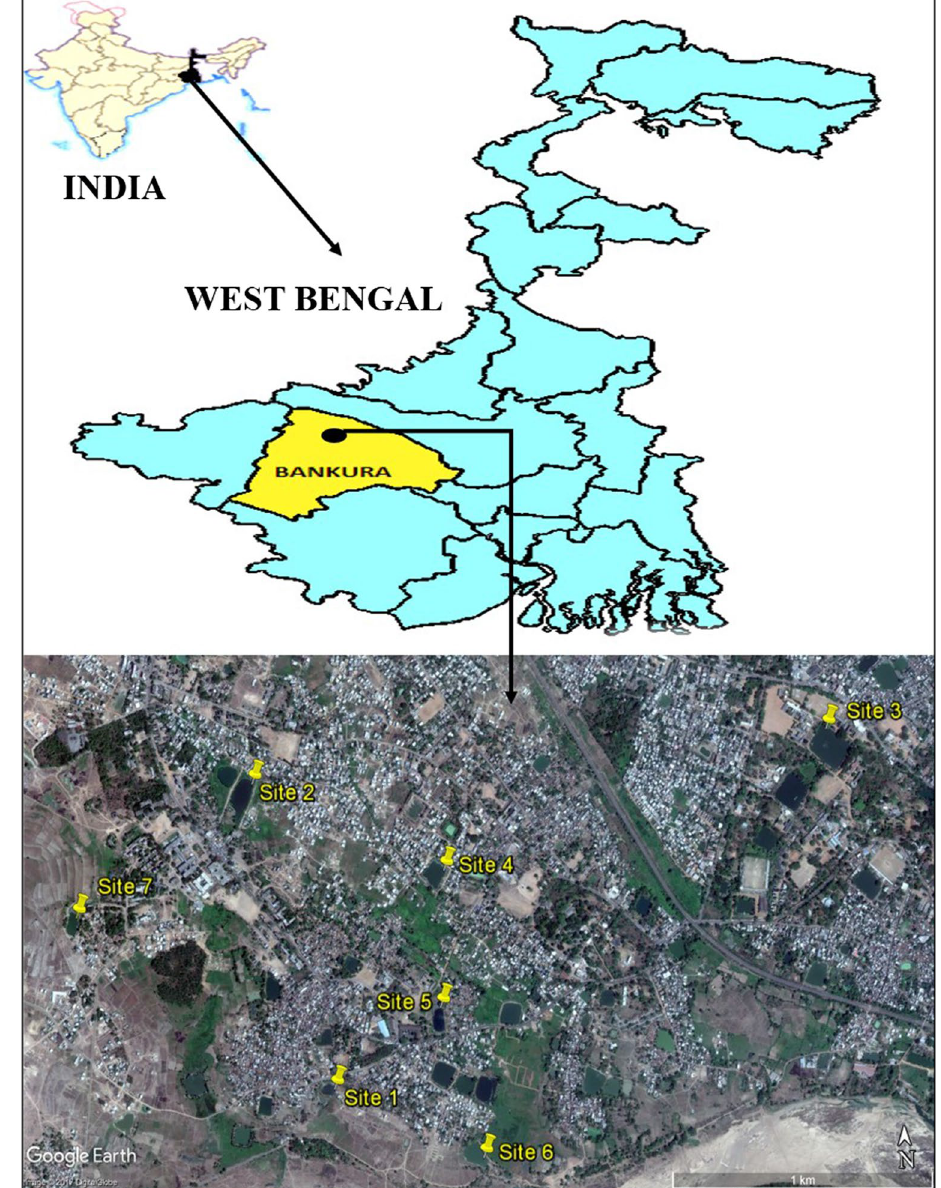
Fig. 1 Map showing the study sites (Sites 1–7; Google Earth, 2017) nearby Bankura town region (India and West Bengal maps are not in